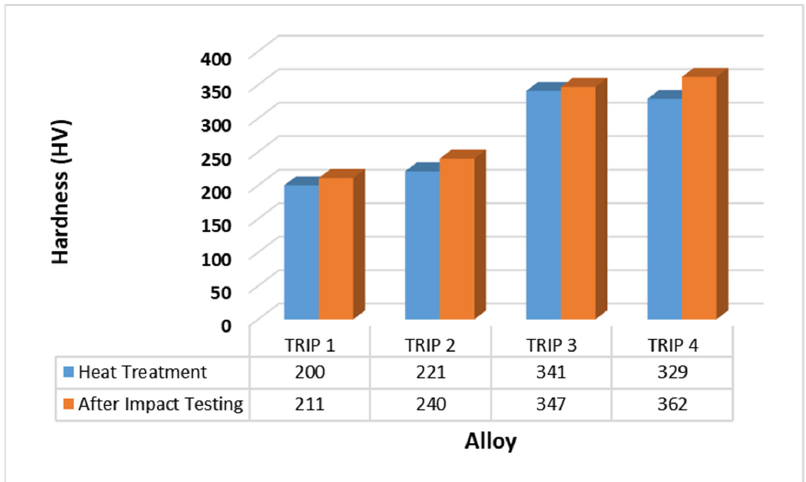
Figure 13. Graphical representation of average Vickers hardness values for TRIP steels after heat treatment and after impact bending test.